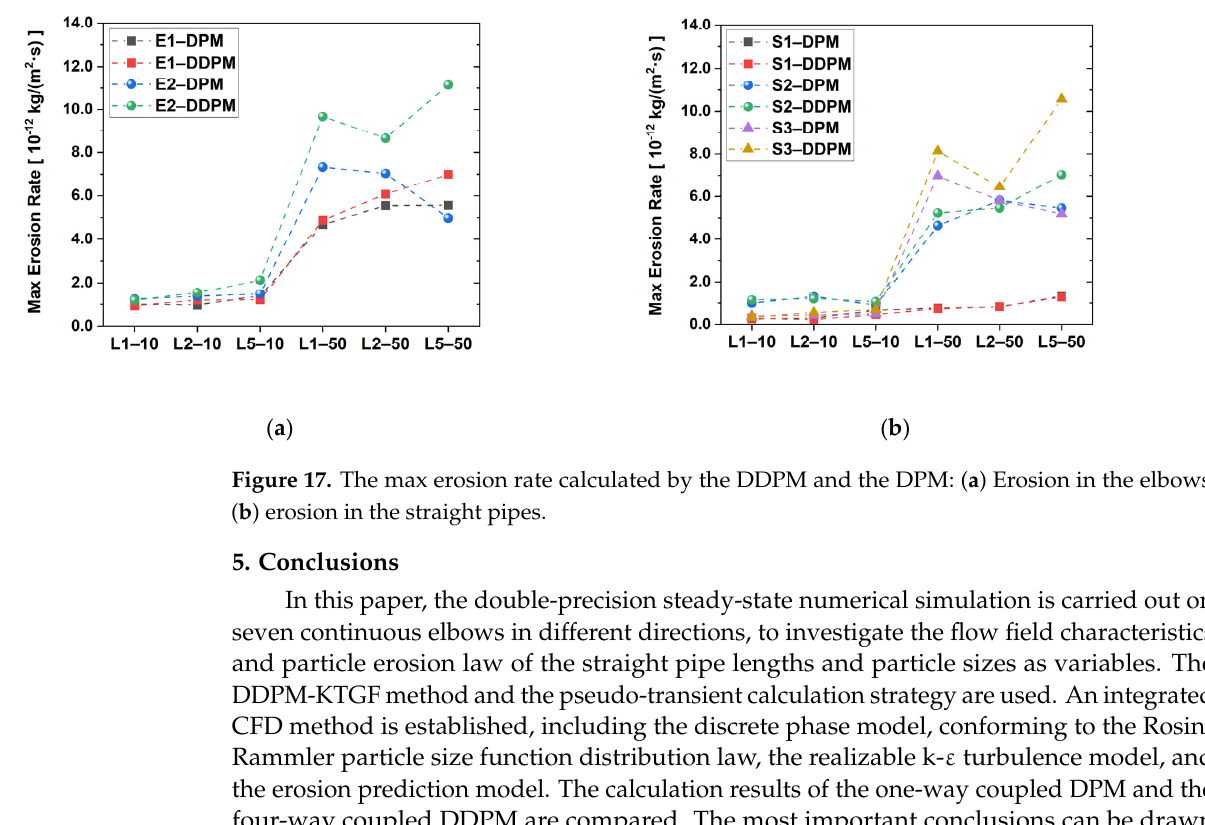
Figure 16. Erosion contours calculated by the DDPM and the DPM. Each pair of rendered colors corresponds to the same erosion range.